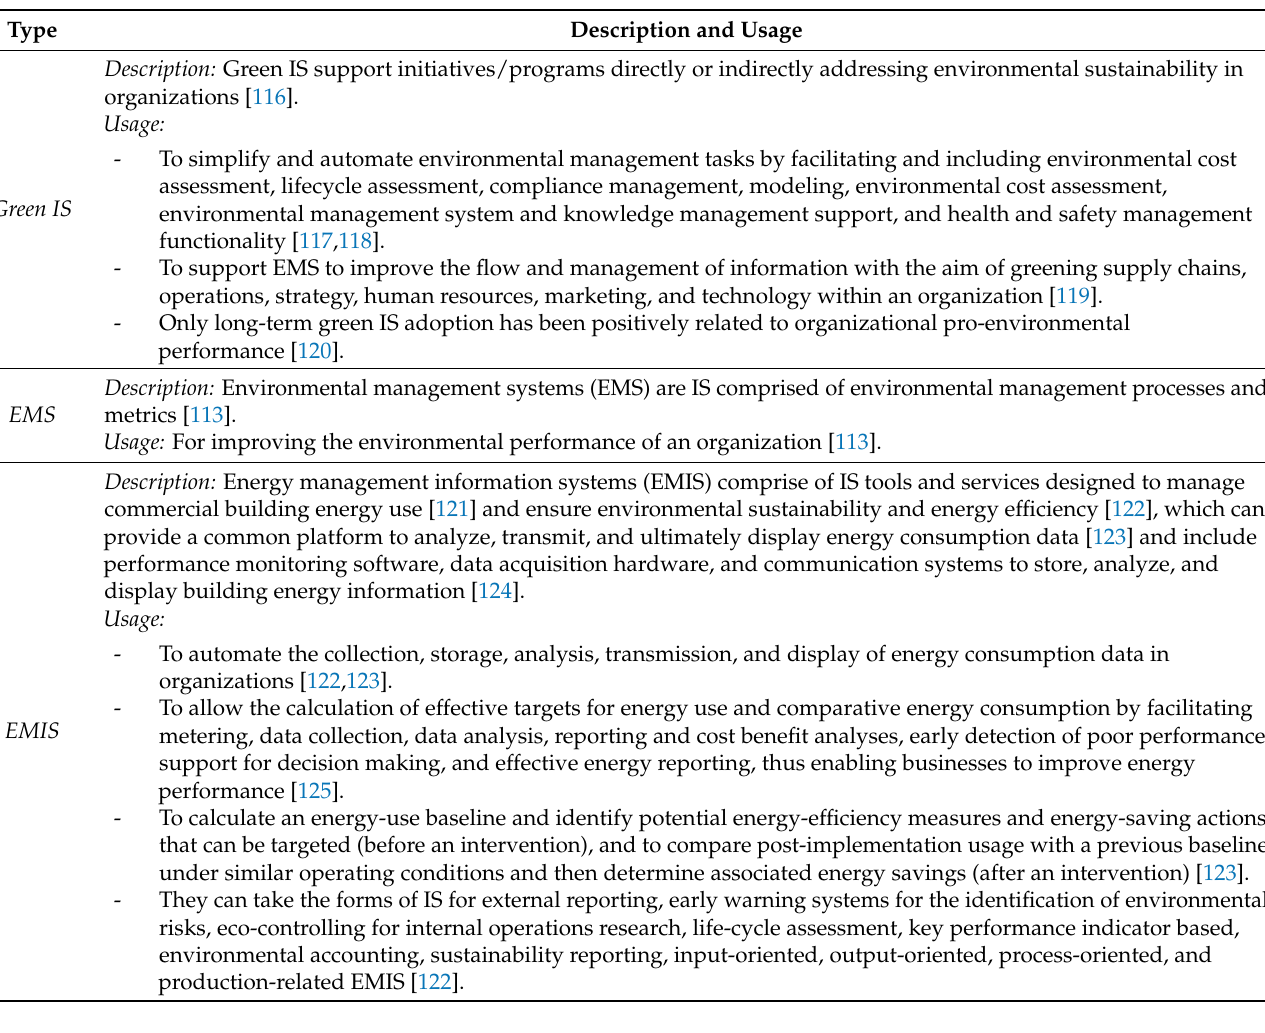
Table 5. Types of IS for organizational energy conservation—description and usage.